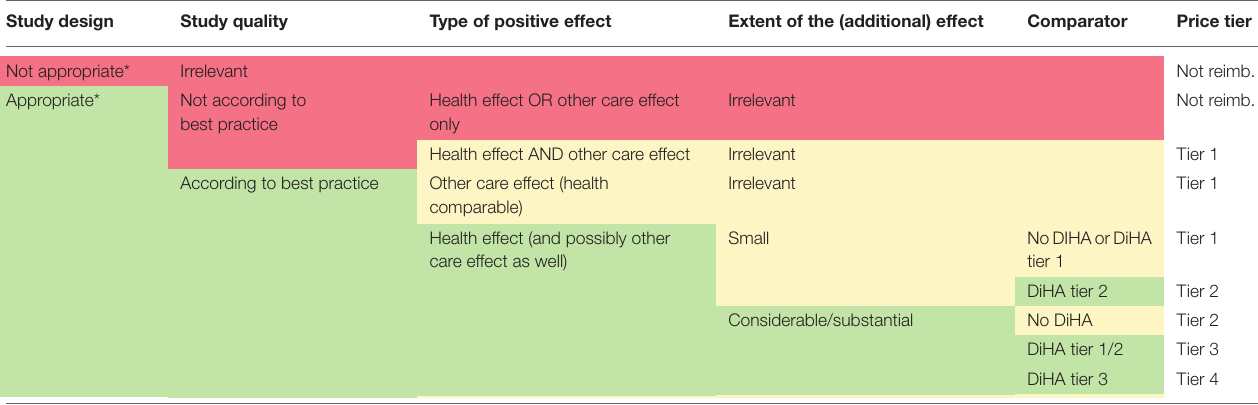
TABLE 5 | Possible price tiers based on the criteria of study results, quality of evidence, and comparator. Study